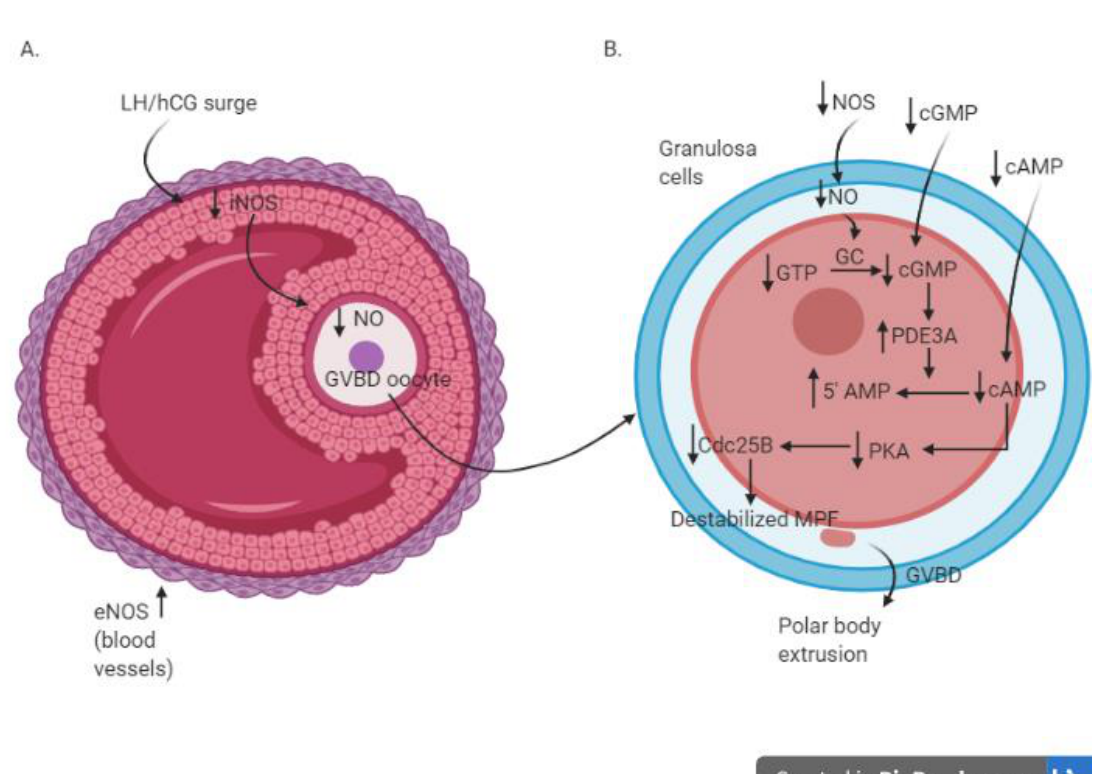
Figure 2. Molecular cascade in antral follicle ( A ) and oocytes ( B ) during the process of GVBD and meiotic resumption after LH surge/hCG administration; cAMP—3 (cid:48) -5 (cid:48) -cyclic adenosine